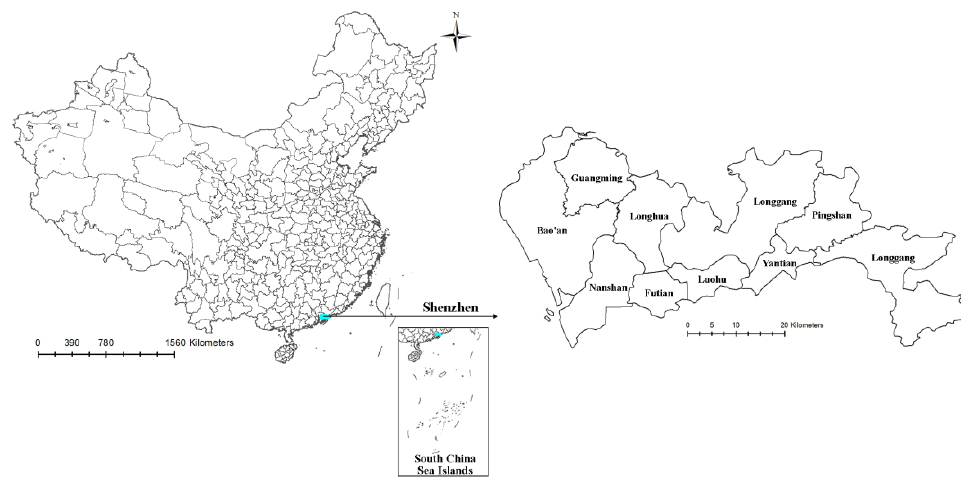
Figure 1. Geographical location of Shenzhen in China.